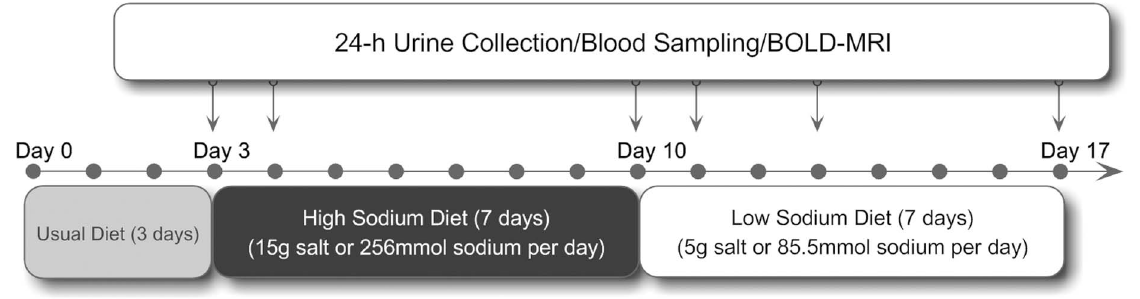
Figure 1. Research protocol.